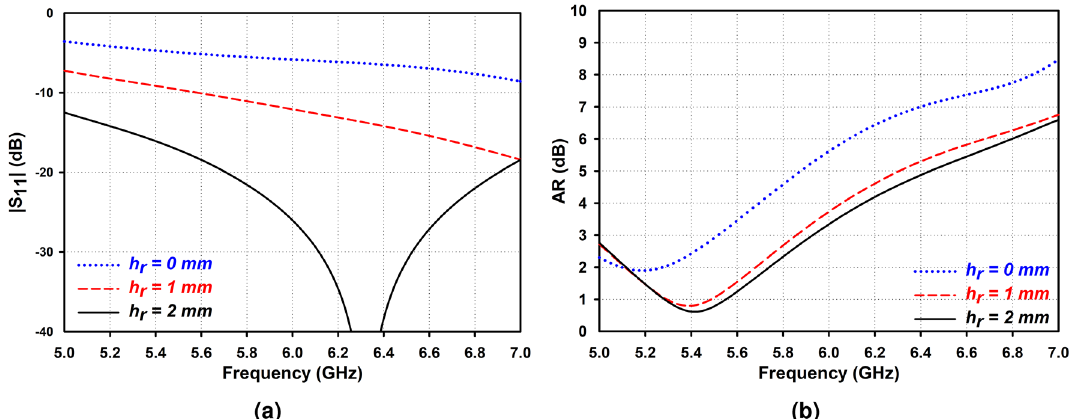
Figure 5. Simulated ( a ) | S 11 | and ( b ) AR of the AAS-DRA with different values of air gaps.